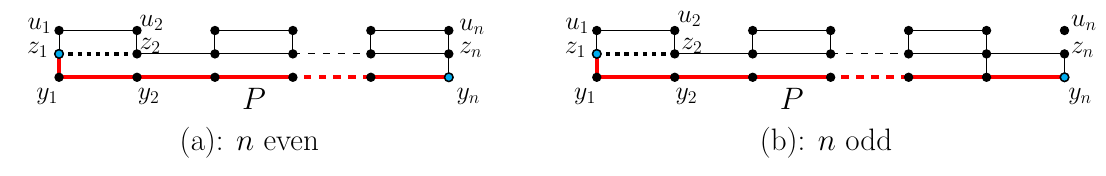
Figure 3: Cycles containing P when m =